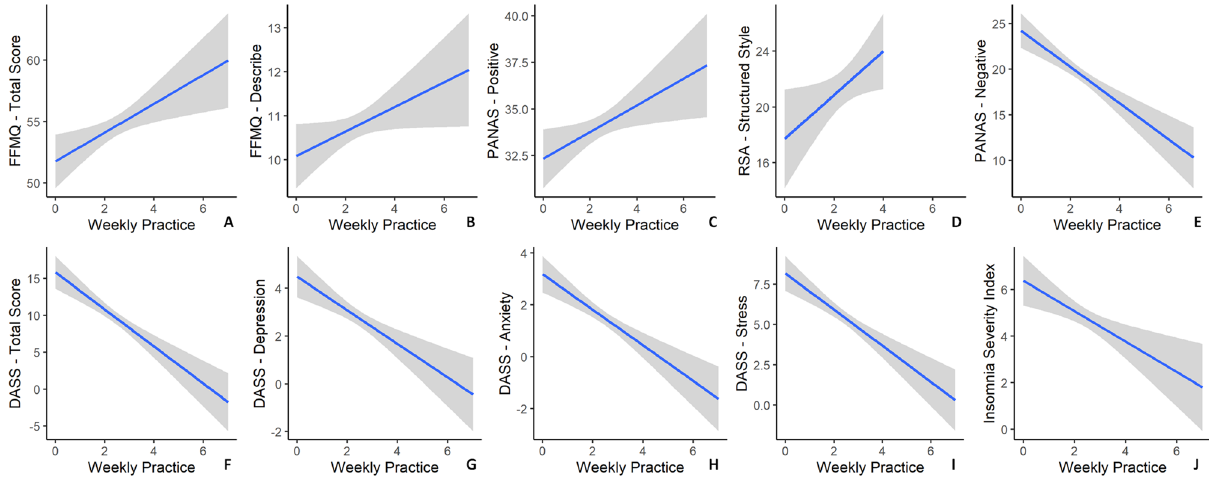
Figure 2. Plots showing significant correlations between the weekly frequency of mindfulness practice and several variables in the intervention group. The x-axis represents the weekly frequency of practice (ranging from 0 to 7 + times a week) and the y-axes represent ( A ) mindfulness total score (FFMQ-15), ( B ) describe subscale (FFMQ-15) ( C ) positive affect (PANAS), ( D ) structured style subscale (RSA) (participants only presented 0 to 4 values on the x-axis in this subsample), ( E ) negative affect (PANAS), ( F ) DASS-21 total score, ( G ) depression subscale (DASS-21), ( H ) anxiety (DASS-21), ( I ) stress subscale (DASS-21), ( J ) insomnia (ISI). The grey shaded area represents 95% confidence